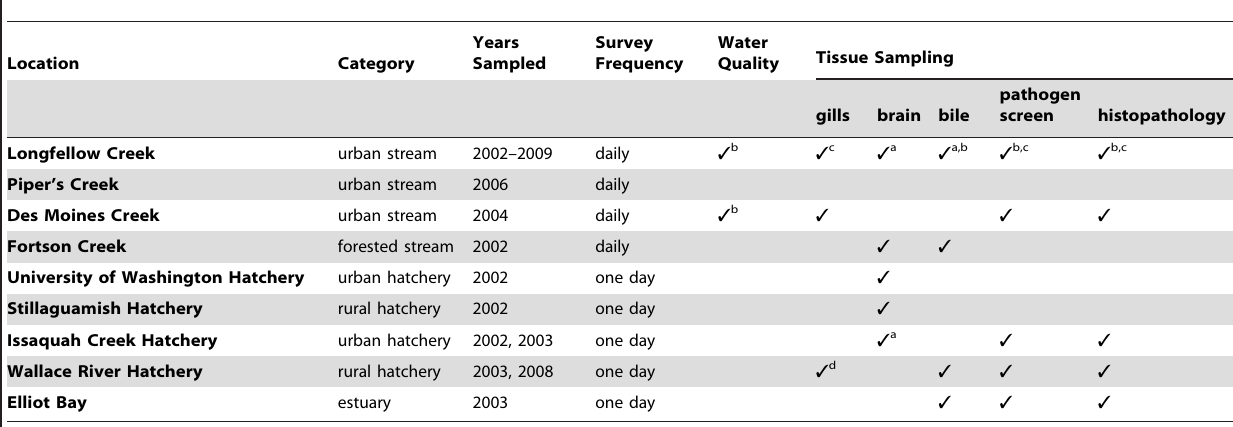
Table 1. Summary of survey locations and associated tissue